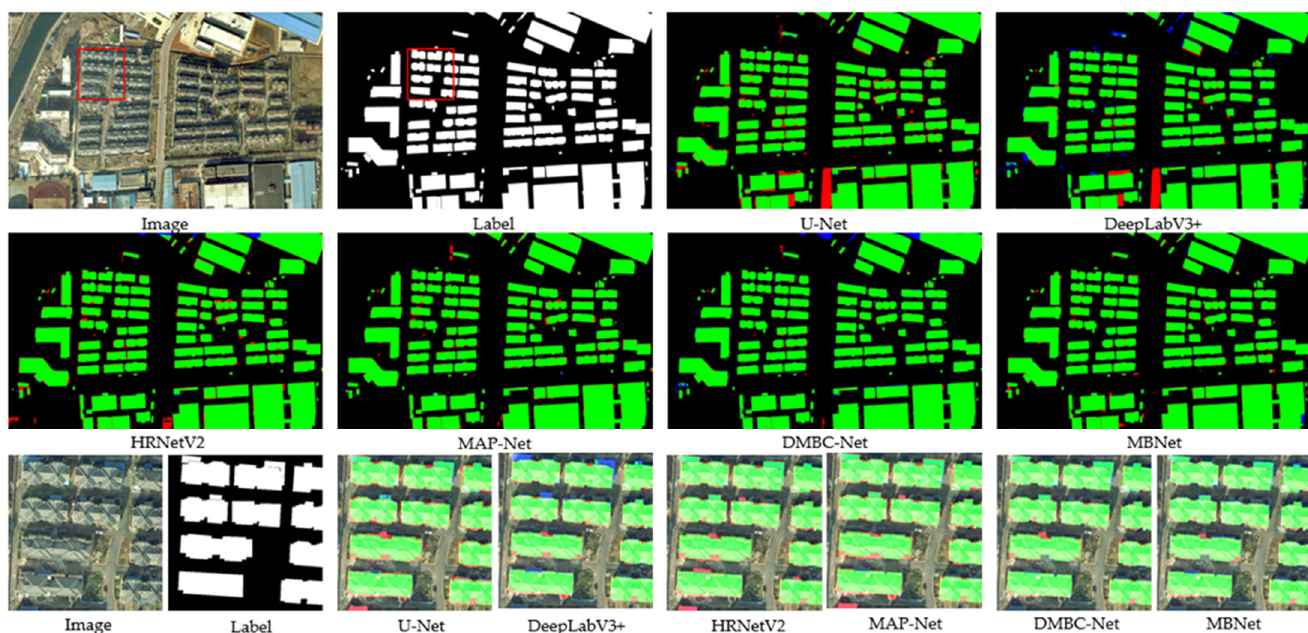
Figure 17. Segmentation results of the different SOTA methods on the suburban dense area scene 3 test dataset. The bottom row is a close-up view of the red box.